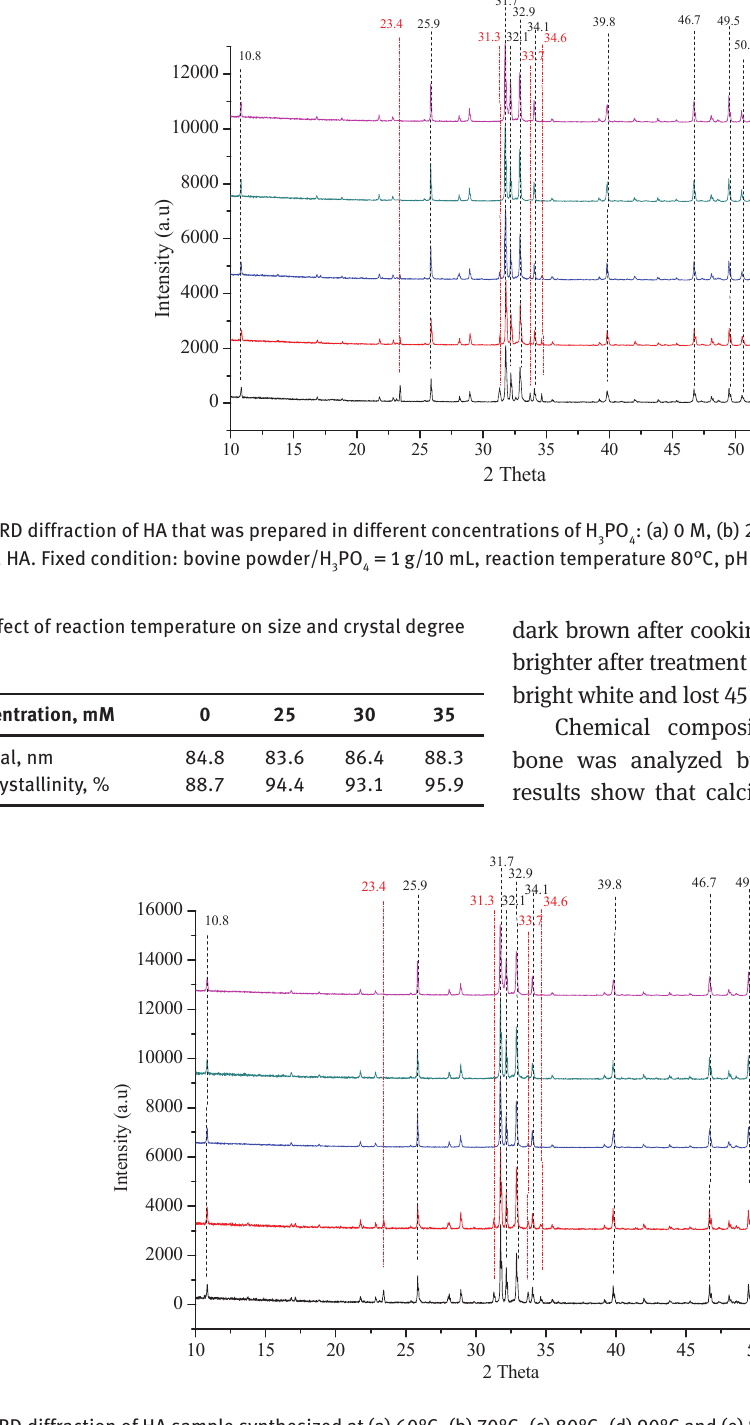
Figure 3: XRD diffraction of HA sample synthesized at (a) 60°C, (b) 70°C, (c) 80°C, (d) 90°C and (e) Standard HA. Fixed conditions: bovine powder/H PO = 1:10 g/mL, H PO (35 mM), pH 11 and calcine temperature 3 4 3 4